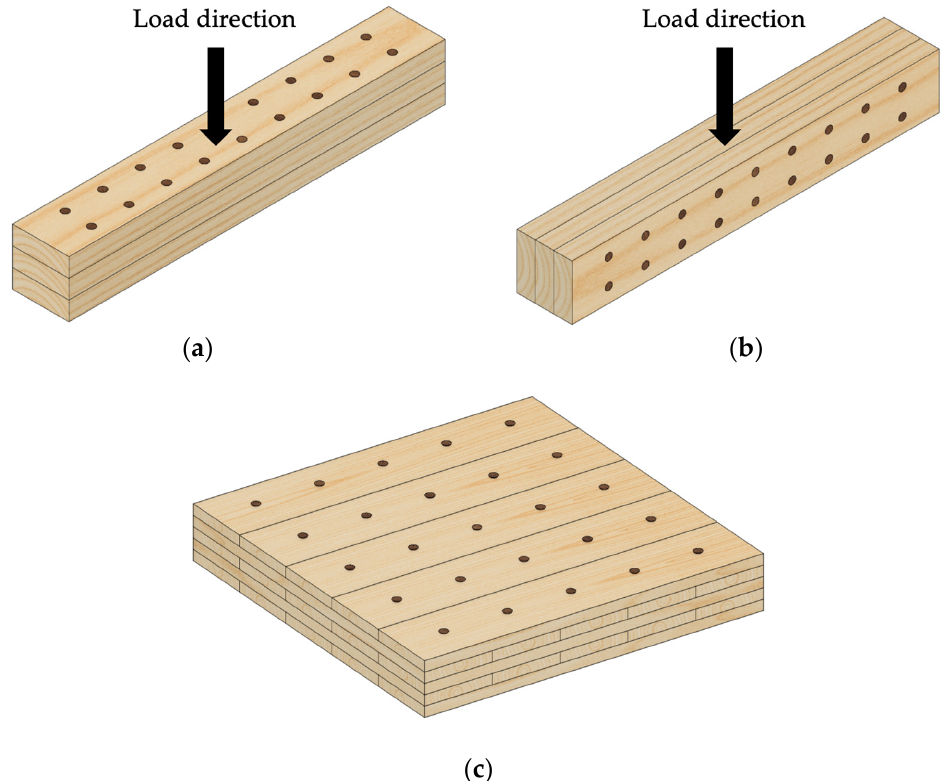
Figure 1. Multi-layered timber EWPs assembled using wooden dowels: ( a ) DLT beam (parallel lamella stack with loading direction parallel to the fiber direction of dowels), ( b ) DLT panel (parallel lamella stack with loading direction vertical to the fiber direction of dowels), and ( c ) DCLT (crossed lamella stack).